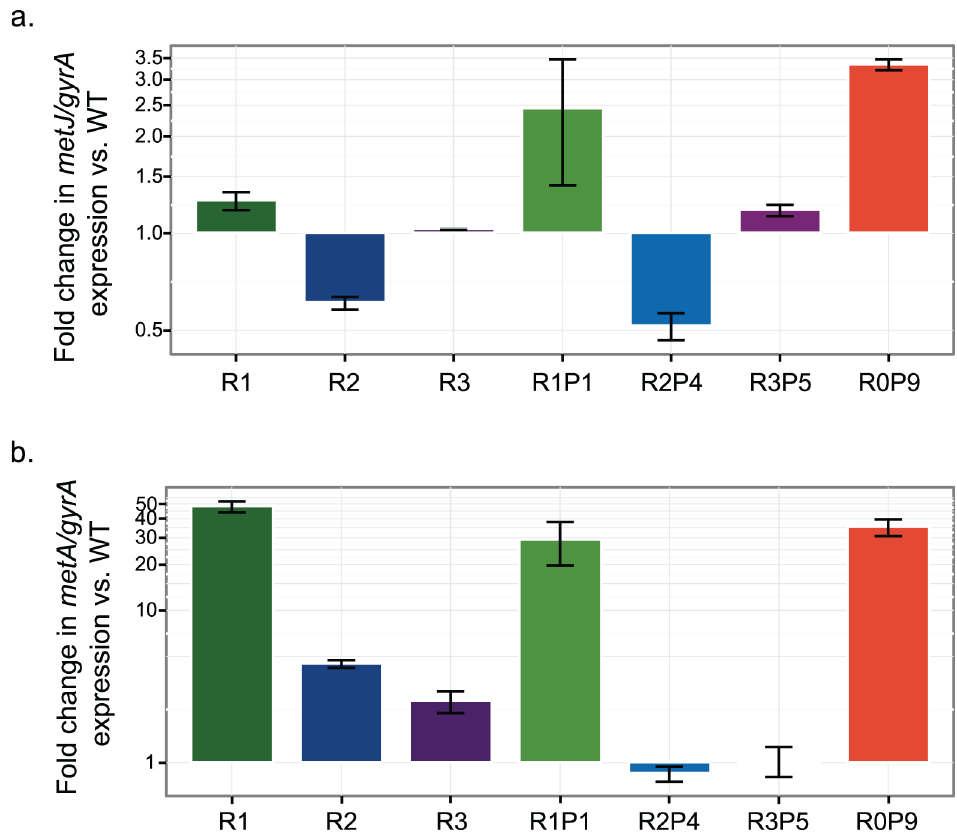
Fig 6. Expression of metJ and metA in R and RP strains relative to wild-type S . enterica . mRNA levels were assayed by quantitative RT-PCR for the strains directly obtaineddue to selection for ethionine resistance or consortia growth in the absenceof methionine. Error bars represent standarderror of three biological replicates.